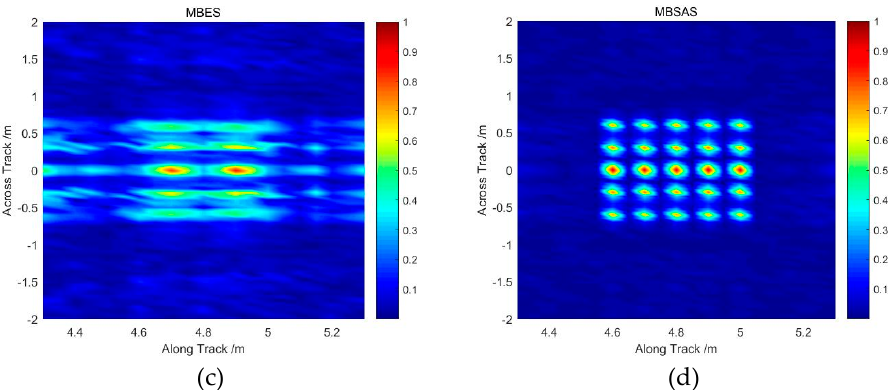
Figure 8. Comparison between imaging algorithms: ( a ) target set and position of carrier; ( b ) imaging result via SAS algorithm; ( c ) imaging result via MBES algorithm; ( d ) imaging result via MBSAS algorithm.